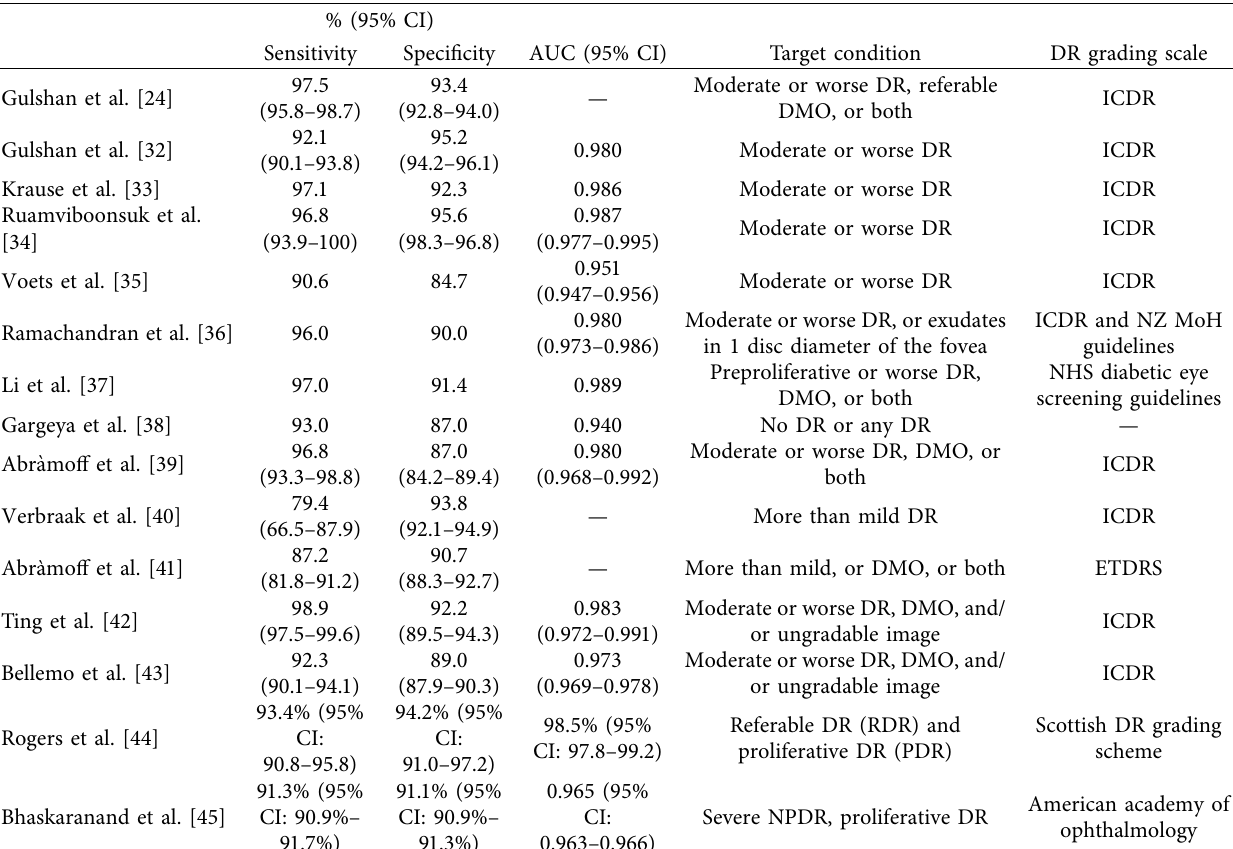
Table 3: Sensitivity, specificity, and AUC validation results of the 15 included studies. Differences in target condition and grading scales made direct comparisons of validation results difficult. AUC � area under the receiver operating characteristic curve; CI � confidence interval; DMO � diabetic macular oedema; DR � diabetic retinopathy; ETDRS � Early Treatment Diabetic Retinopathy